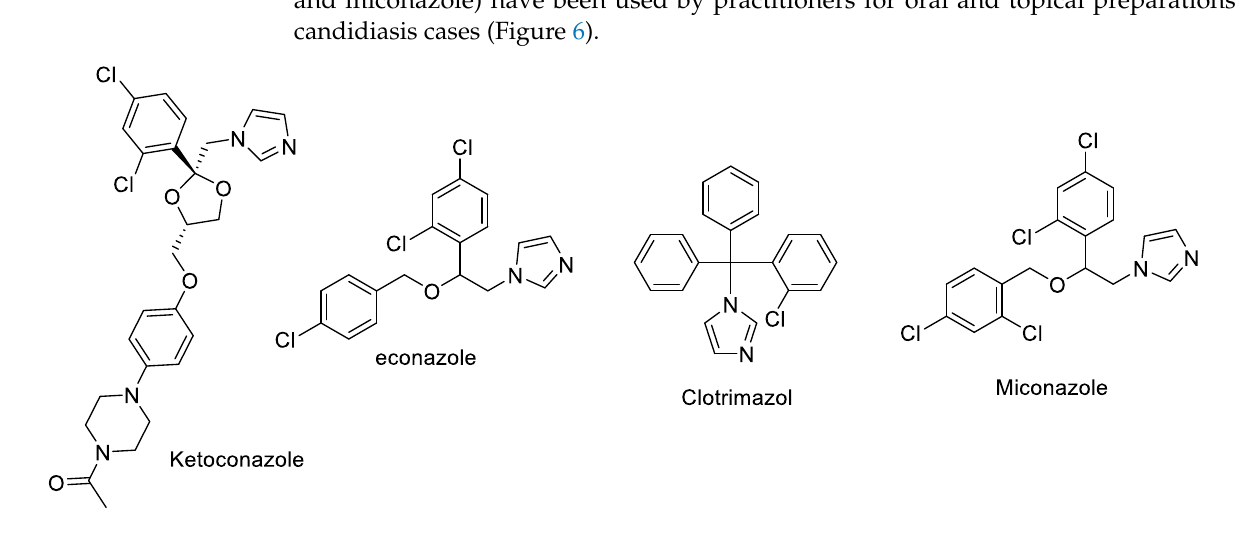
Figure 6. Chemical structure of azoles derivatives as antifungal.